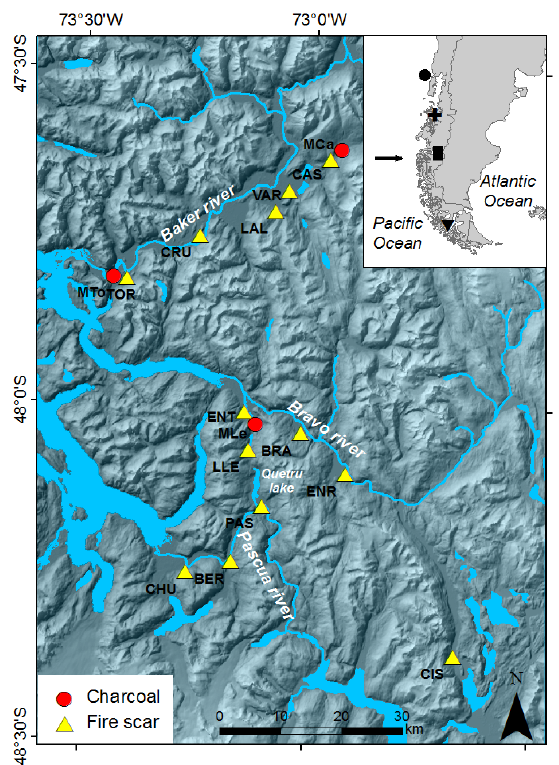
Fig. 1. Map of the study area in central Patagonia showing coring and fire scar sites in the Baker, Bravo and Quetru-Pascua water- sheds. In the inset map of southern South America (SSA), black rectangle, arrows, black circle, black cross, and black triangle rep- resent the study area, the southerly westerly winds (SWW) predom- inant direction and latitudinal fluctuation, precipitation reconstruc- tions (and hence, the position of the SWW) at 41 ◦ S (Lamy et al., 2001), 44 ◦ S (Sep´ulveda et al., 2009), and 53 ◦ S (Lamy et al., 2010), respectively. Site characteristics are outlined in Tables S1 and S2 in the